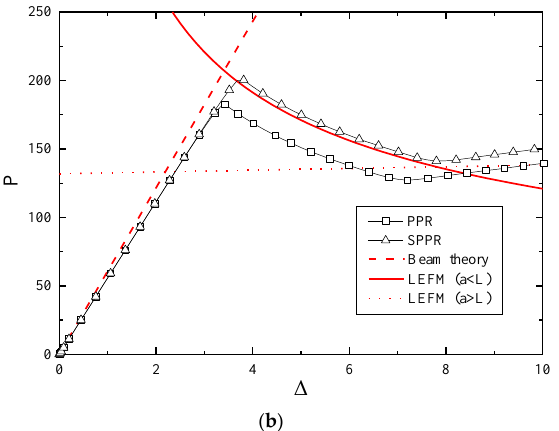
Figure 11. Computational results for different models ( a ) considering the same facture energy ( 𝜙 𝑛 = 𝜙 𝑡 = 1N m⁄ ), or ( b ) considering different facture energies ( 𝜙 𝑛 = 1N m⁄ 𝑎𝑛𝑑 𝜙 𝑡 = 2N m⁄ ).